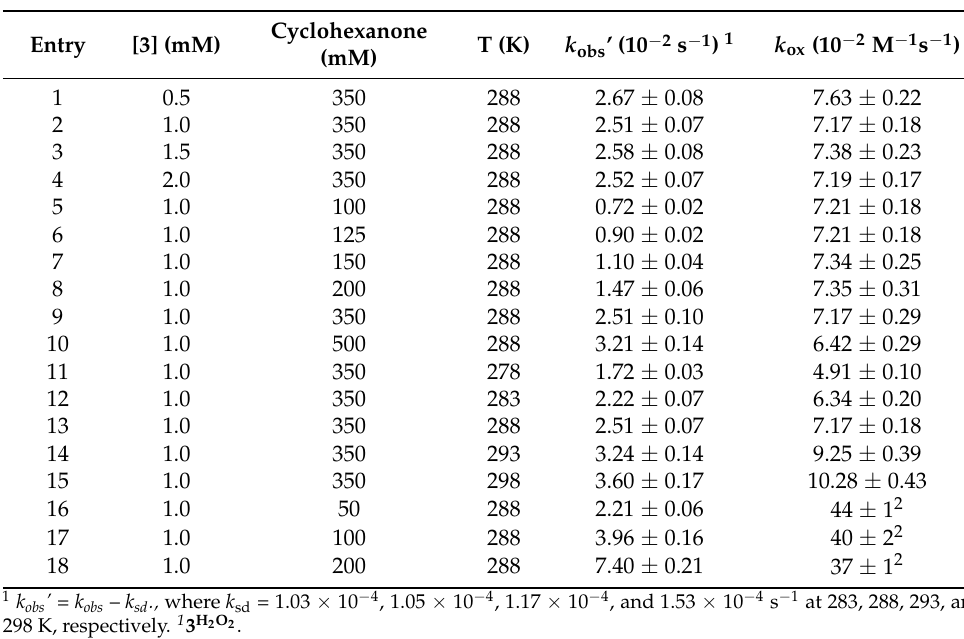
Table 7. Kinetic data for the stoichiometric Baeyer–Villiger oxidation of cyclohexanone with 3 PhIO and 3 H 2 O 2 .